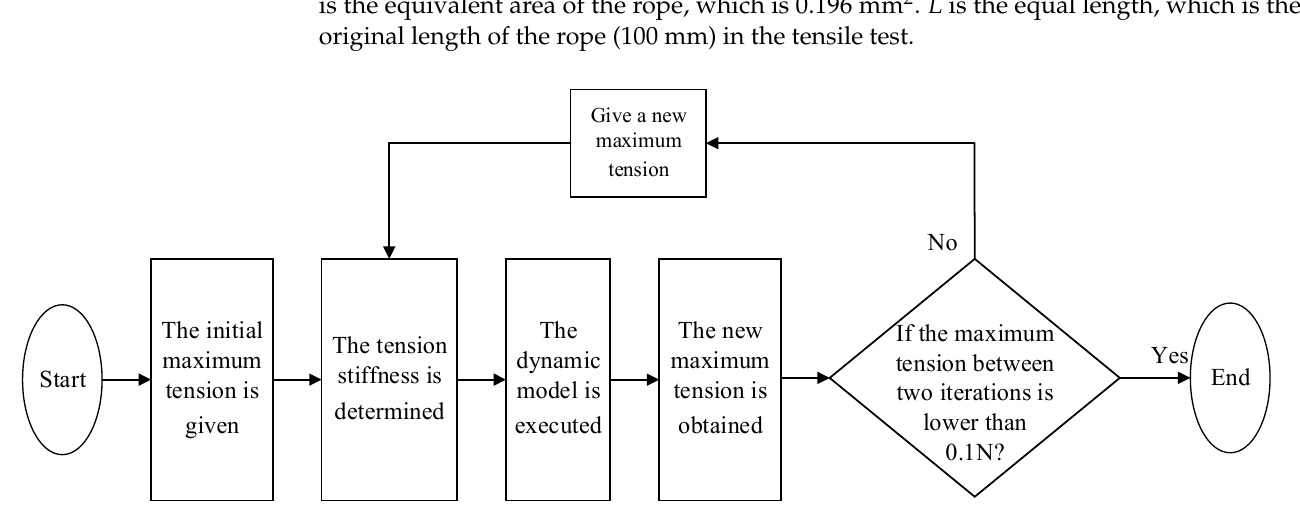
Figure 8. Line segment tension during deployment.